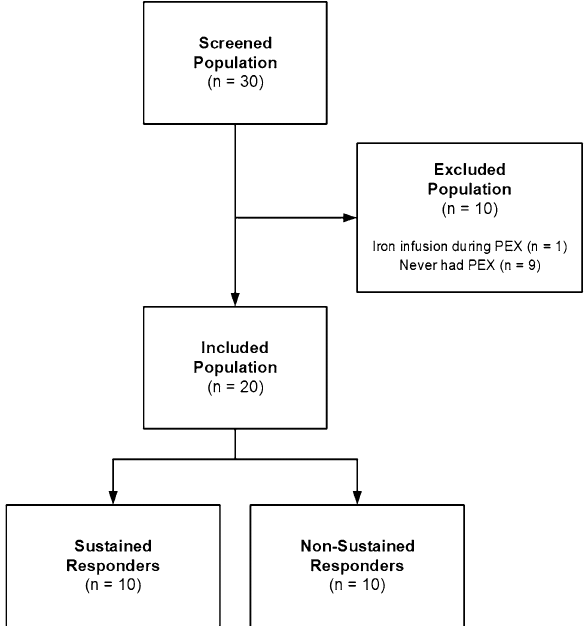
Figure 1. STROBE diagram showing subject flow during the